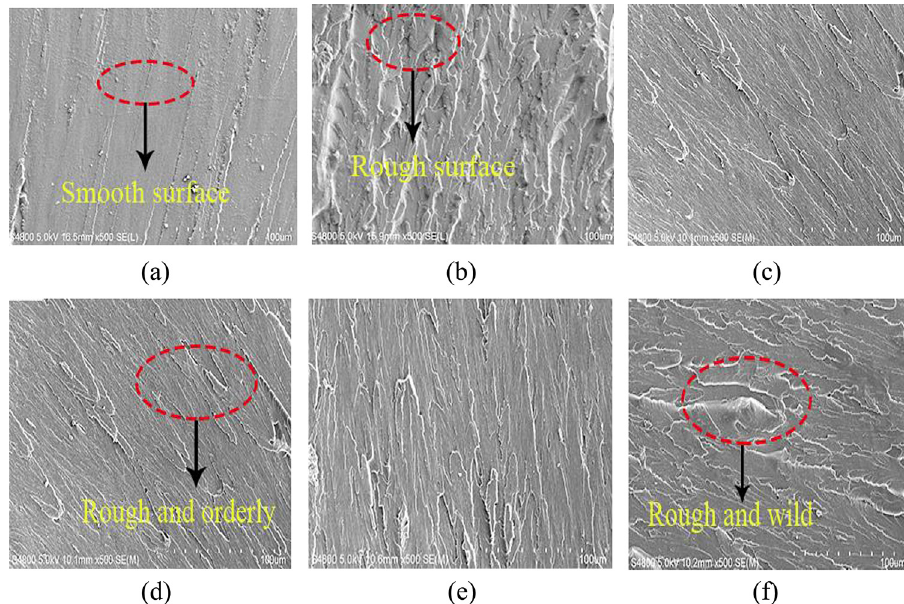
Figure 12: Scanning electron microscopic of tensile section of the parts before and after modi fi cation: ( a ) blank resin, ( b ) unmodi fi ed TiO 2 , ( c ) 1 wt% TiO ( d ) 1.5 wt% TiO ( e ) 2 wt% TiO ( f ) 2.5 wt% TiO 2 , 2 , 2 , and 2